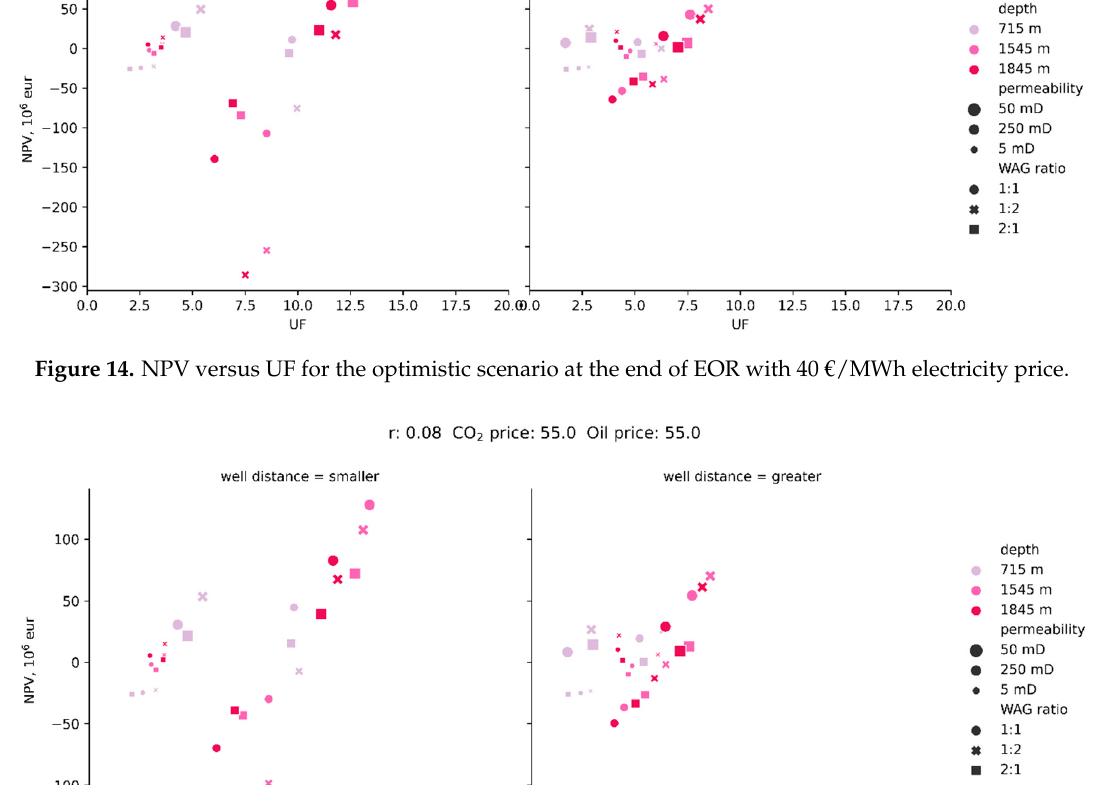
Energies 2021 , 14 , x FOR PEER REVIEW